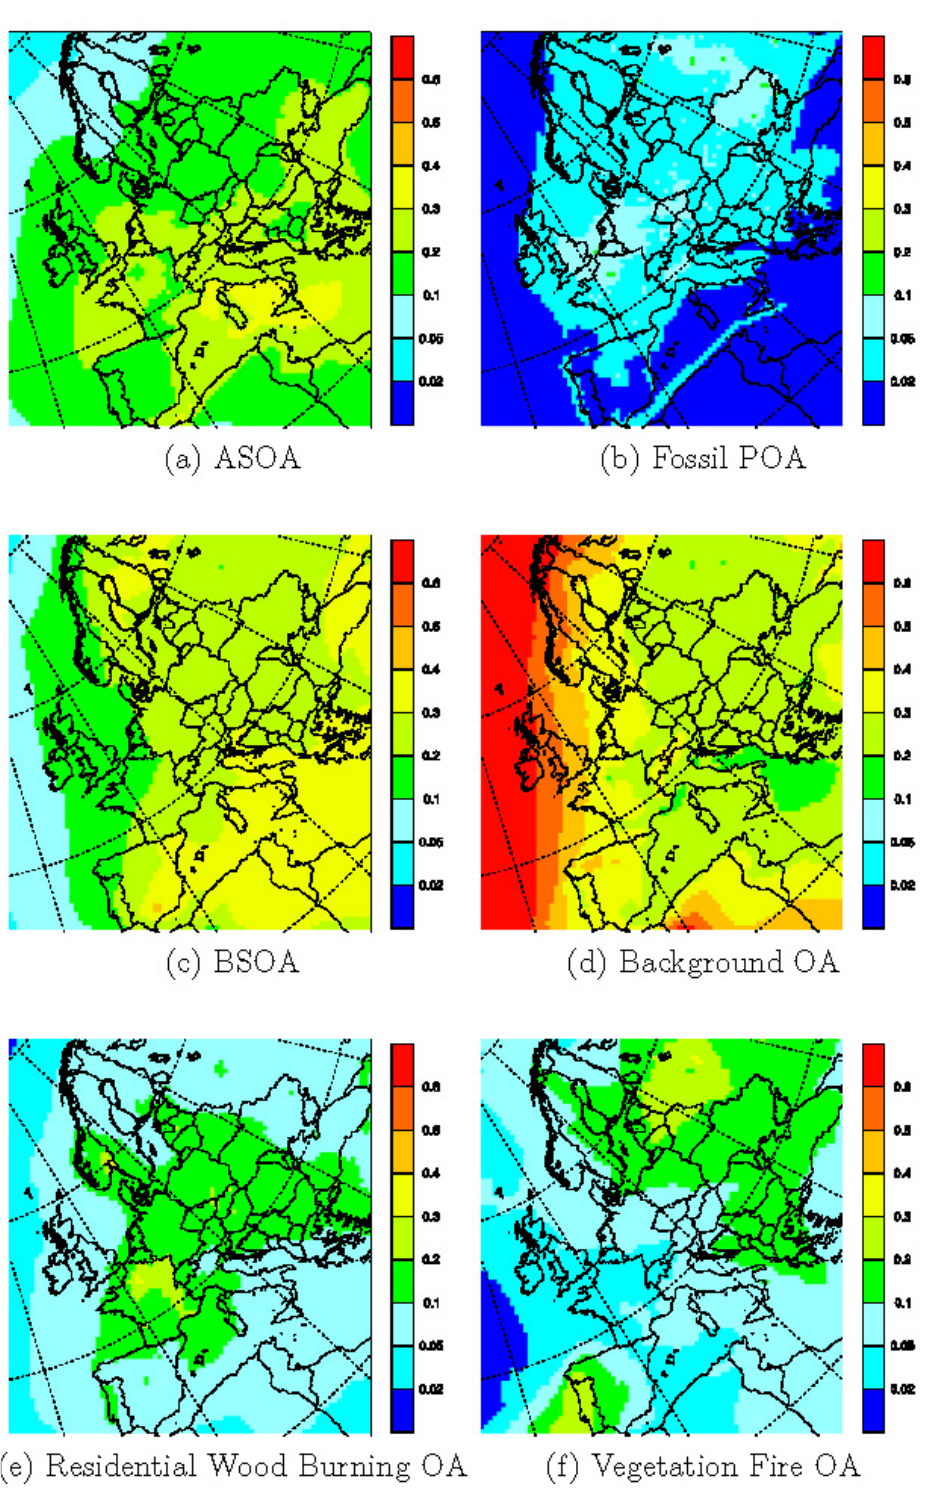
Fig. 4. Calculated relative contribution to organic matter in PM 2 . 5 (OM PM of OM PM from (a) anthropogenic SOA (from AVOC and fossil fuel S/IVOC, i.e., ASOA V 2 . 5 aerosol (POA), (c) biogenic SOA (from BVOC), (d) background organic aerosol (from sources not explicitly included in the model), (e) residential wood combustion (primary + SOA SI ), (f) vegetation fires (primary + SOA SI ). Average for the 6-yr period